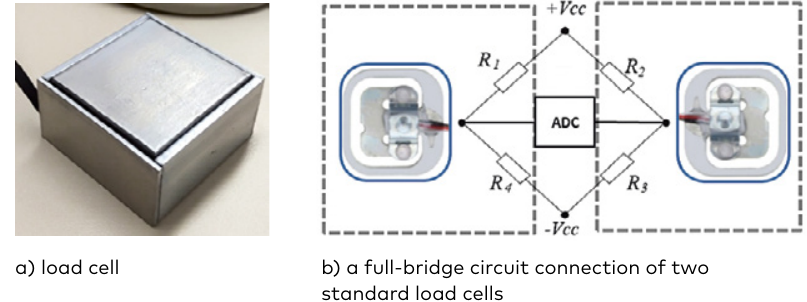
Figure 3. Load cells structure for ballast pressure measurement